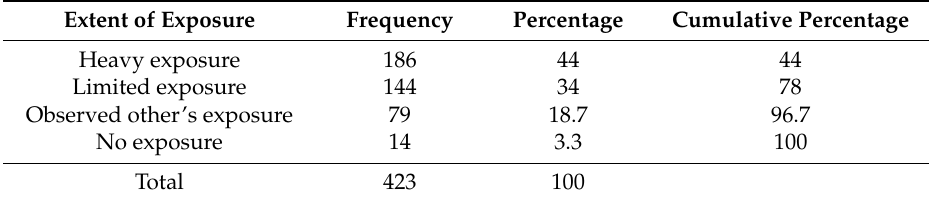
Table 3. Respondents’ exposure to urban floods.